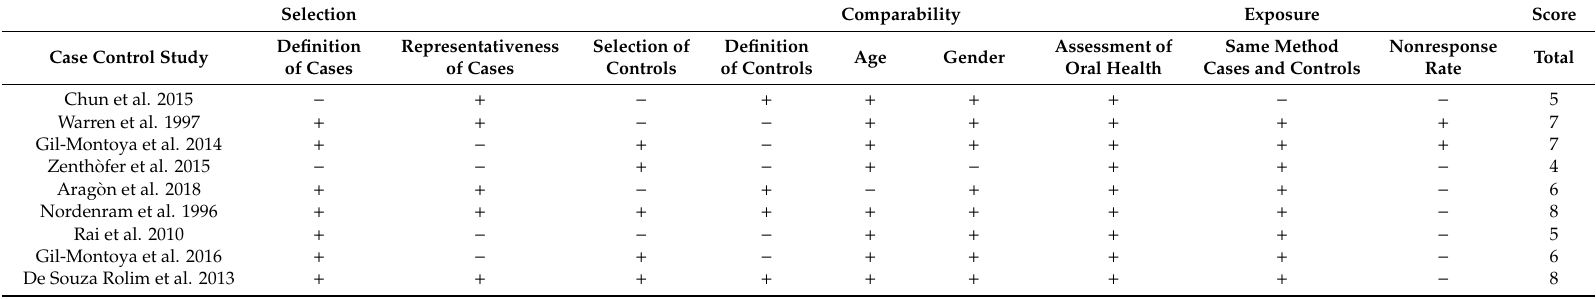
Table 4. Assessment of risk of bias within the studies (Newcastle–Ottawa scale) with scores. (4–5 scores: Low quality, 6–7 scores: Intermediate quality, 8–9 scores: High